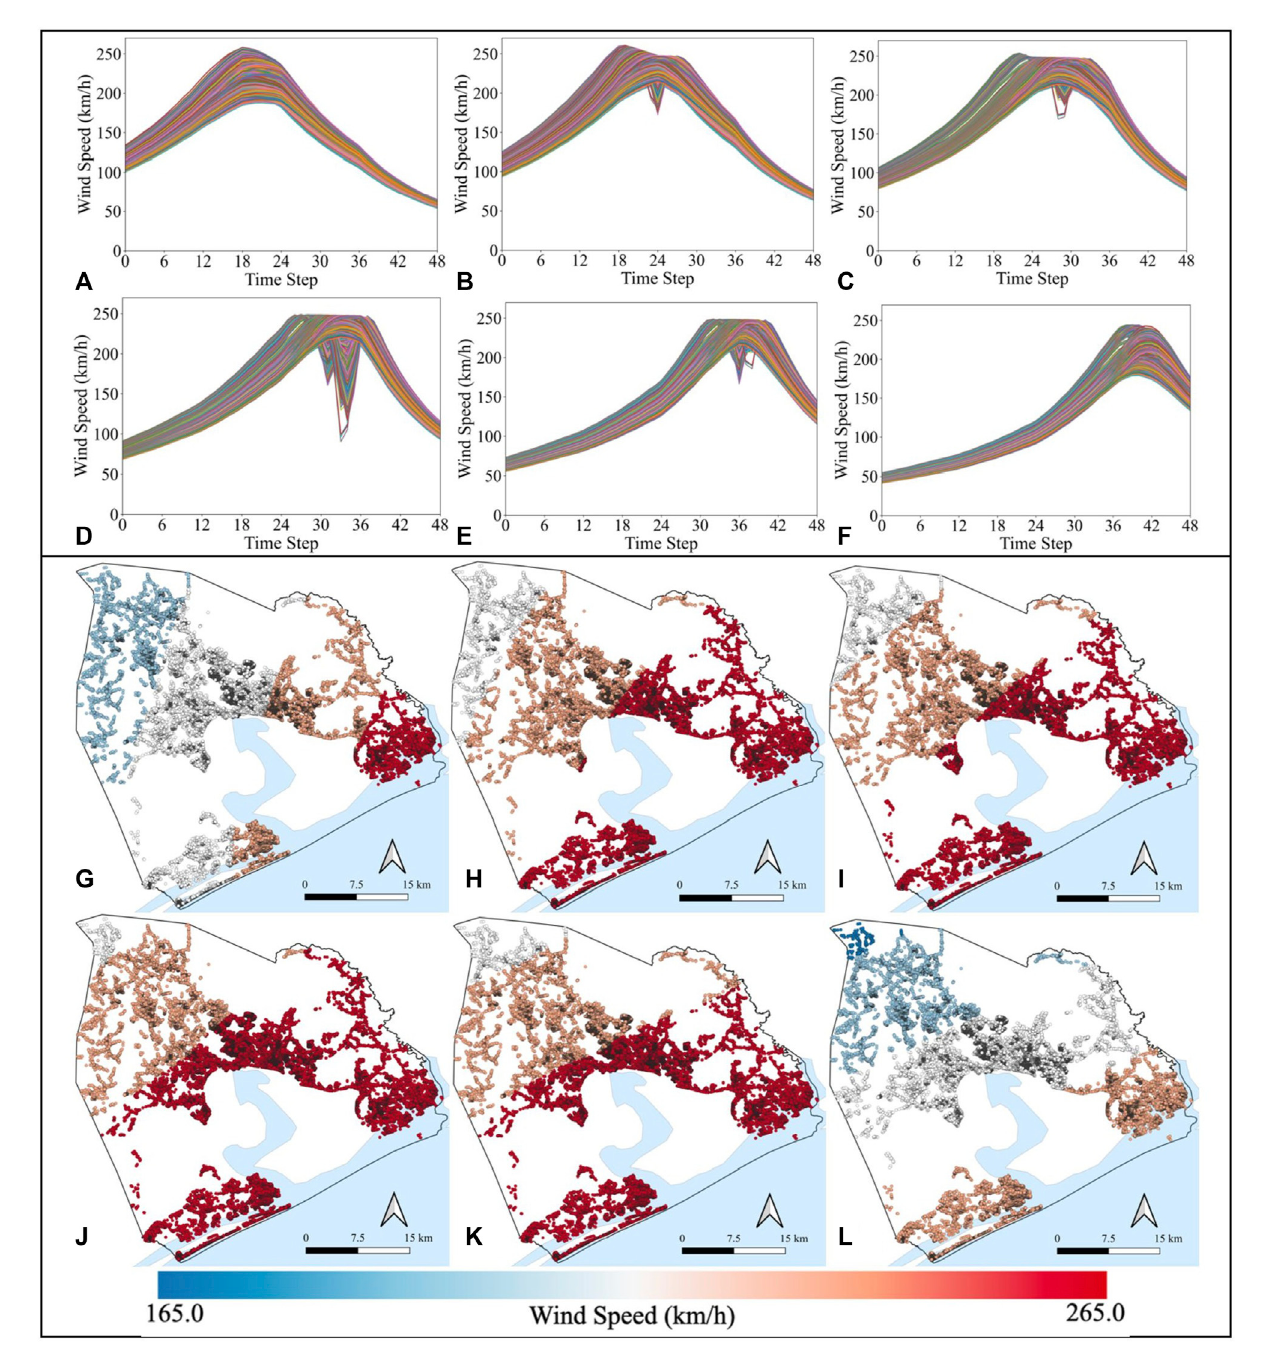
FIGURE 7 Wind speed trajectory for 59,692 buildings due to hurricanes: (A) P1, (B) P2, (C) P3, (D) P4, (E) P5, and (F) Helene, and Maximum peak gust wind speed maps for hurricanes: (G) P1, (H) P2, (I) P3, (J) P4, (K) P5, and (l)